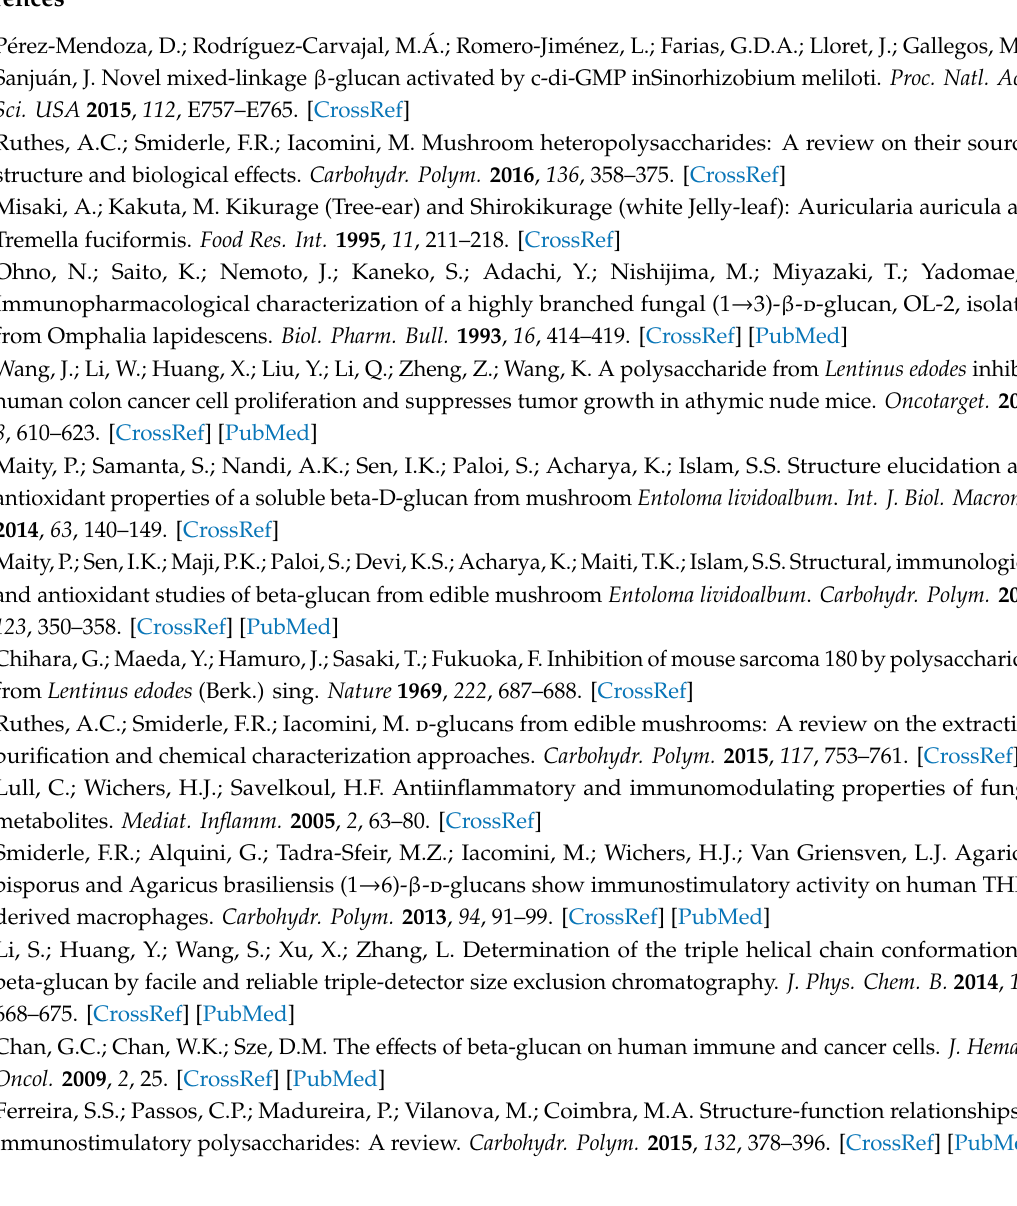
methylation. Figure S3: The 1 H- 1 H COSY spectrum of